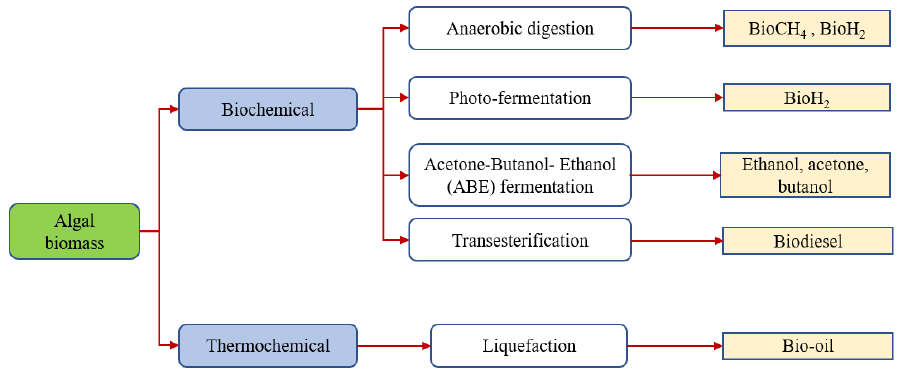
Figure 5. Production of biofuels from microalgae .